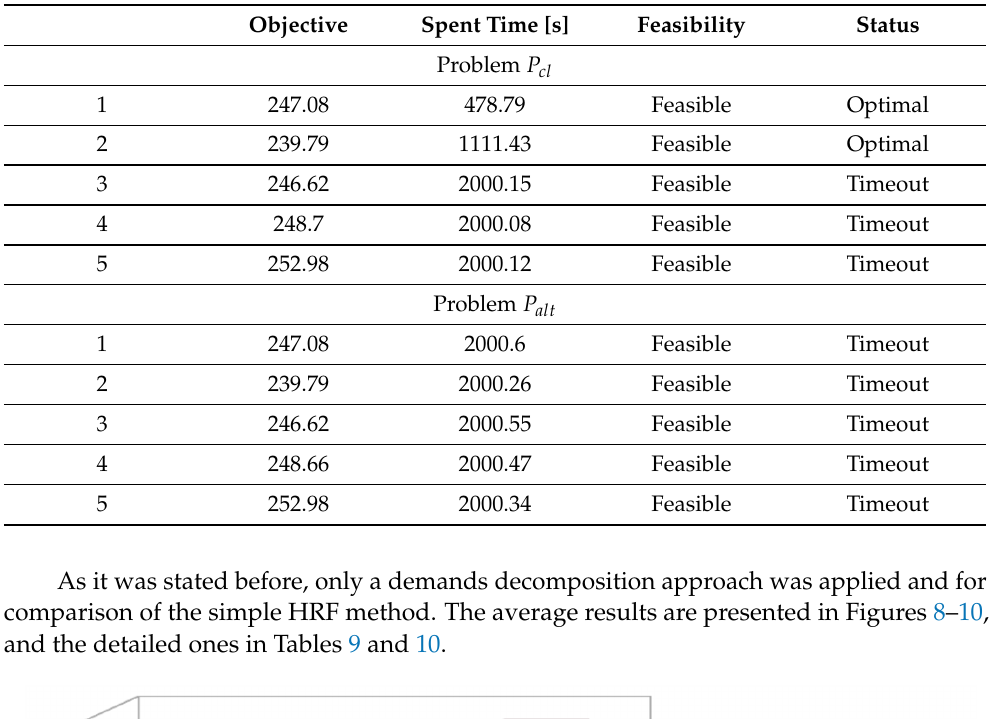
Table 8. Numerical results for large problems—CPLEX solver.